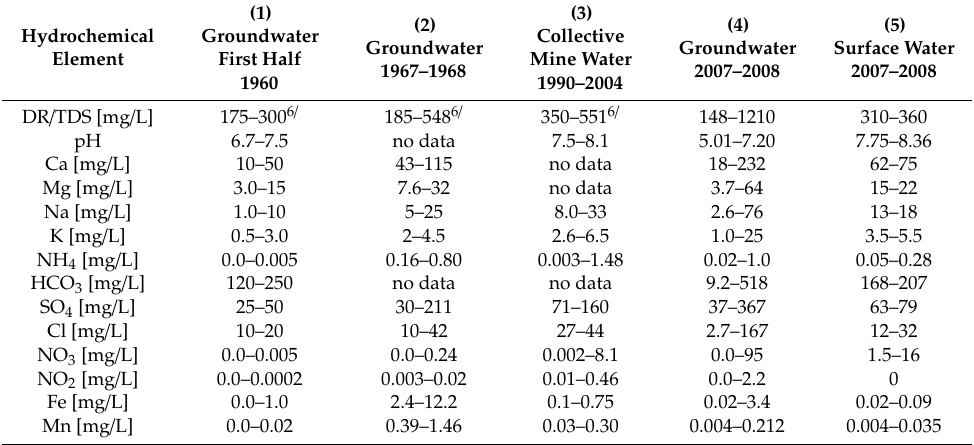
Table 2. Water chemistry in the area of the Ku´znica War˛e˙zy´nska excavation in the period from the first half 60s of the 20th century to 2008 (based on